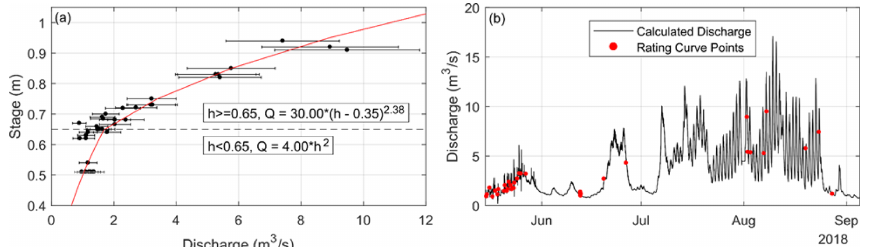
Figure 15. (a) Rating curve and (b) calculated 2018 discharge for the Peyto Creek.